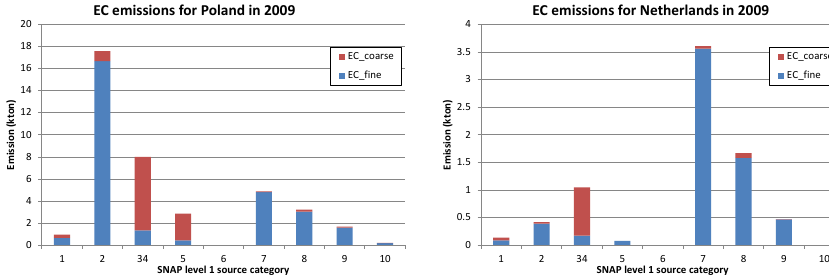
Figure 7. EC emissions in Poland (left panel) and the Netherlands (right panel) per SNAP level 1 source category in 2009.